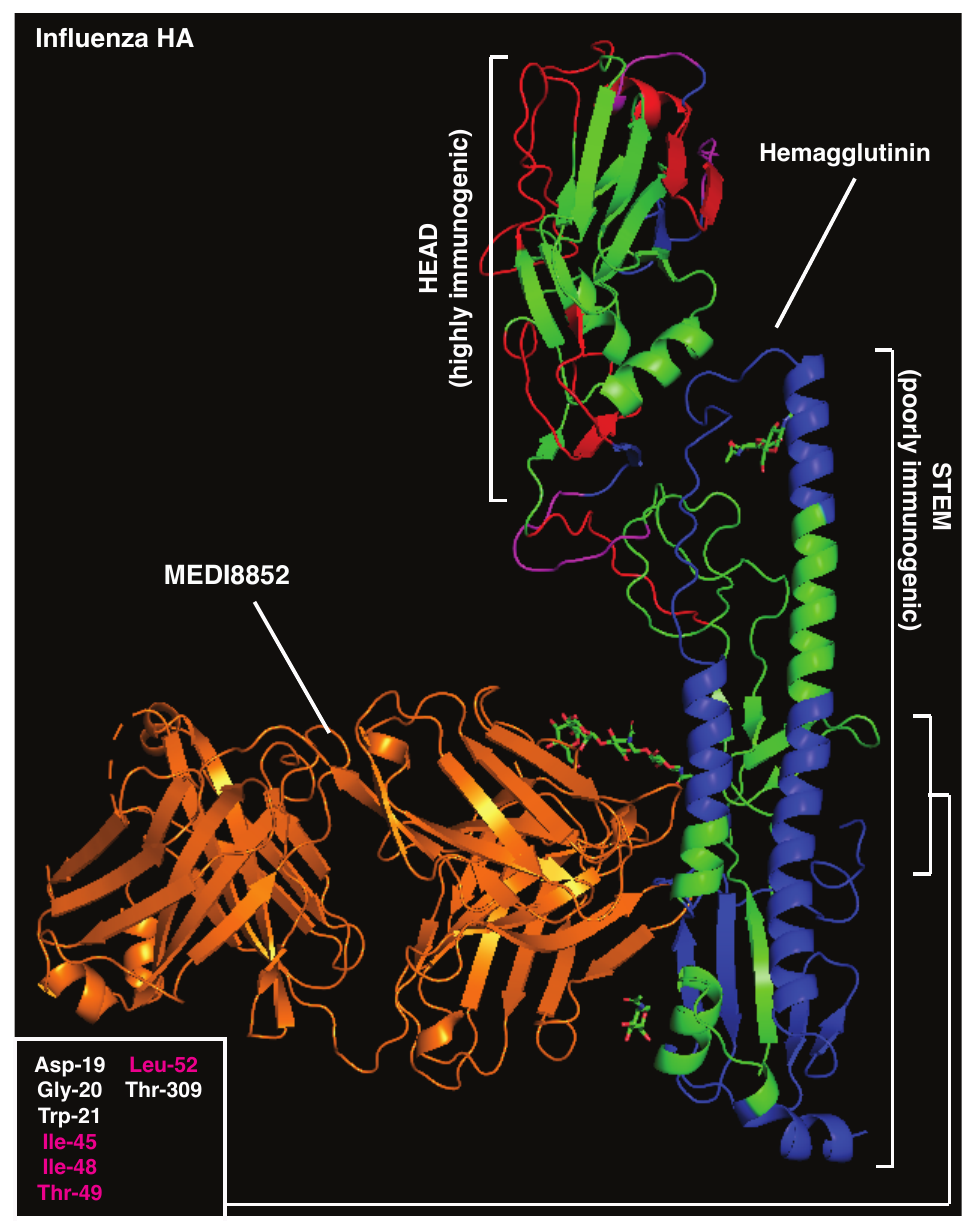
Figure 4. Crystal structure of influenza hemagglutinin and MEDI8852 bnAb (PDB:5JW3). Immun- odominant B-cell epitopes are depicted in red, while dominant CD4 determinants are highlighted in blue. Amino acids essential for MEDI8852 binding are listed (bottom left) and those overlapping with CD4-dominant regions are highlighted in